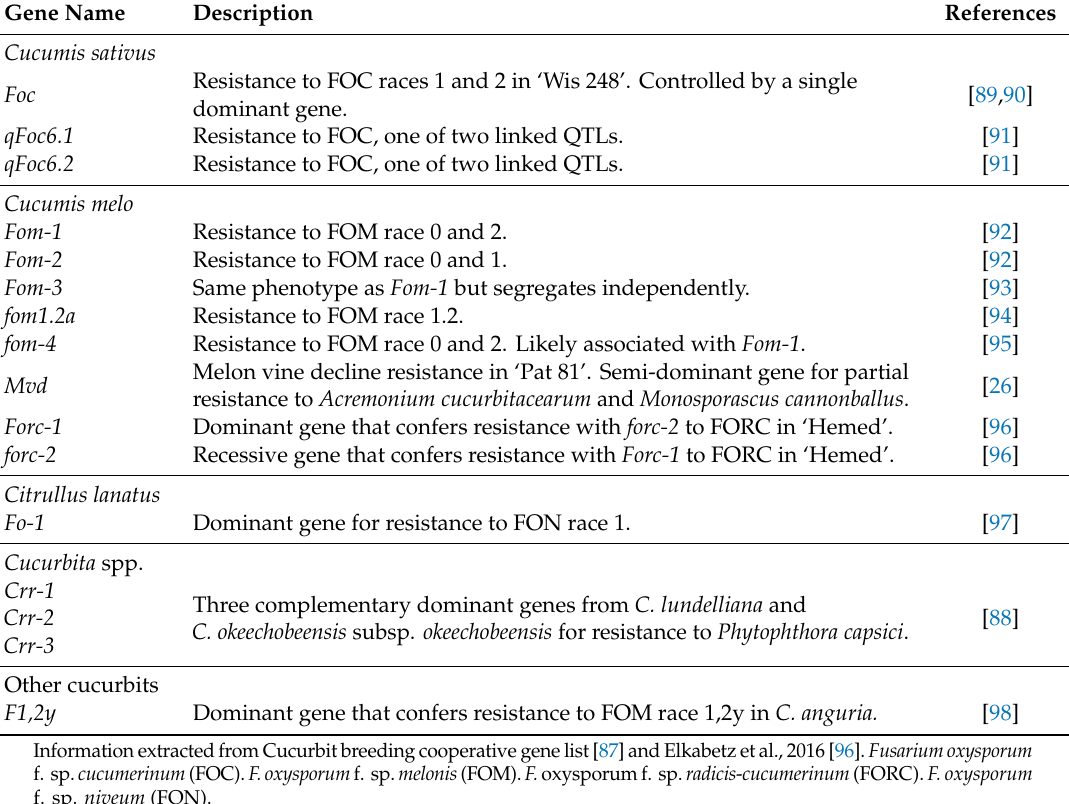
Table 2. Resistance genes related to soil-borne fungal pathogens in cucurbitaceous